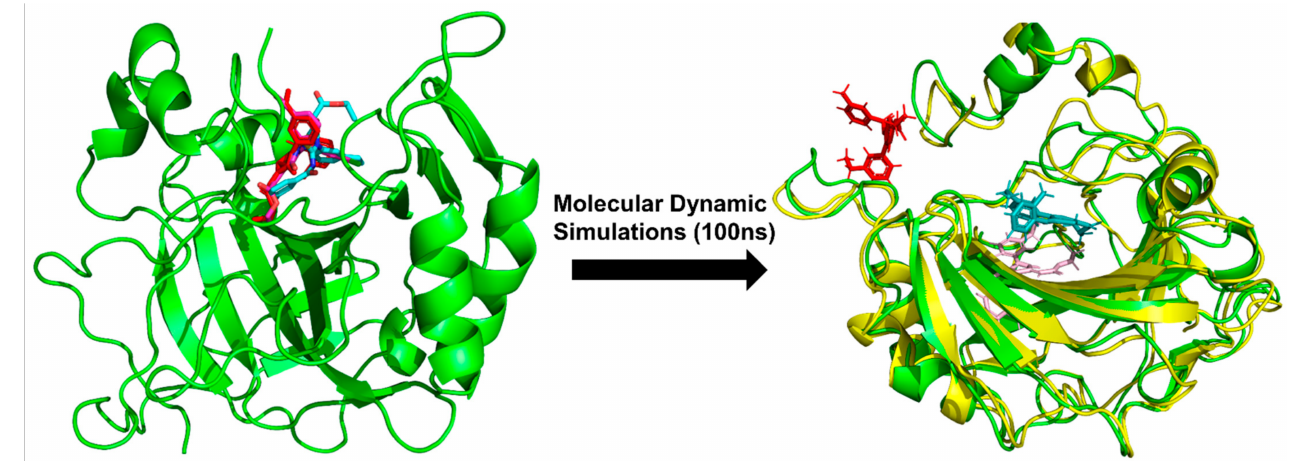
Figure 12. An illustration of pose clustering obtained during MD simulations. Left-side conformations were retrieved from molecular docking on the basis of energy rankings. During MD simulations, right-side pose clustering (dynamic state) was observed; red color represents compound 6g , light pink represents compound 6e , and blue-colored ligand represents compound 6a